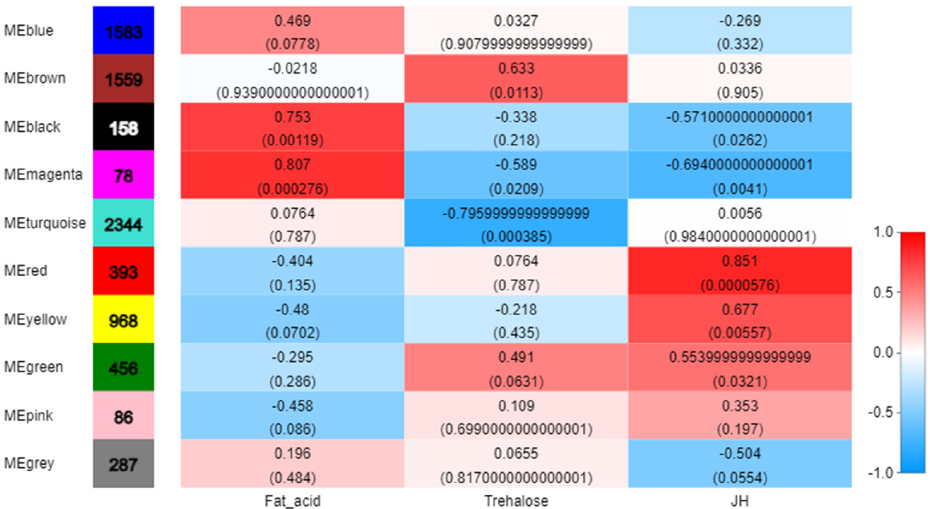
Figure 7. Correlation of modules with each physiological index. Horizontal coordinates represent fatty acids, trehalose, and JH, and vertical coordinates represent different gene modules. The left column of the graph indicates the number of genes in the module, and each set of data on the right indicates the correlation coefficient and significant p -value (in parentheses) of the module with the phenotype. The default designation of red and blue means that the module is more and less correlated with the phenotype, as indicated by the numbers under the color bar at the bottom right.